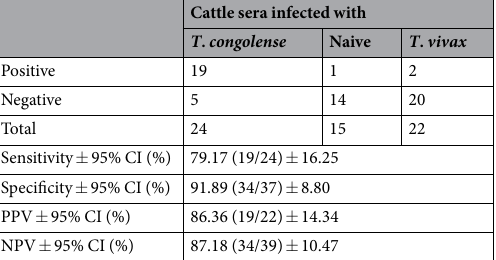
Table 2. Preliminary evaluation of sensitivity, specificity, positive and negative predicted values for the Nb44/ Nb42 LFA performed on plasma samples from experimentally infected cattle. The samples were obtained from